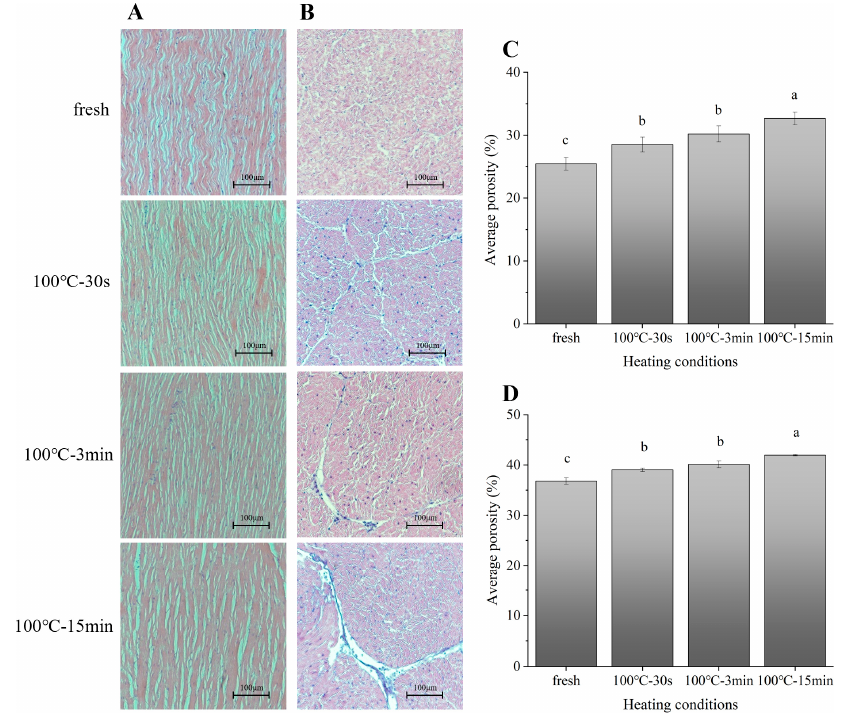
Figure 3. Light micrographs of longitudinal sections ( A ) and cross-sections ( B ) of SAMs after boiling stained by HE at 100× field of view. ( C ) Average porosity of longitudinal sections of samples; ( D ) Average porosity of cross-sections of samples; 100 °C–30 s, 30-s-boiled sample; 100 °C–3 min, 3-min-boiled sample; 100 °C–15 min-, 15-min-boiled sample; values with different superscript letters indicate significant differences at the level of p < 0.05.